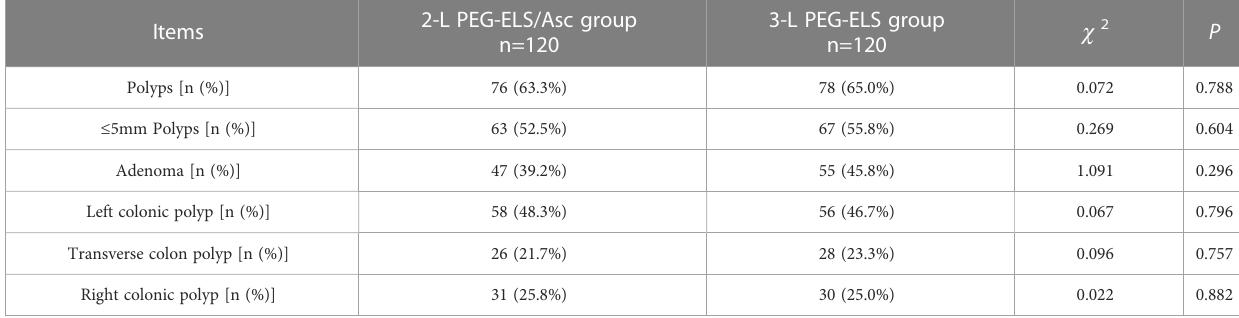
TABLE 5 Comparison of the detection rates of large intestinal polyps between the two groups.